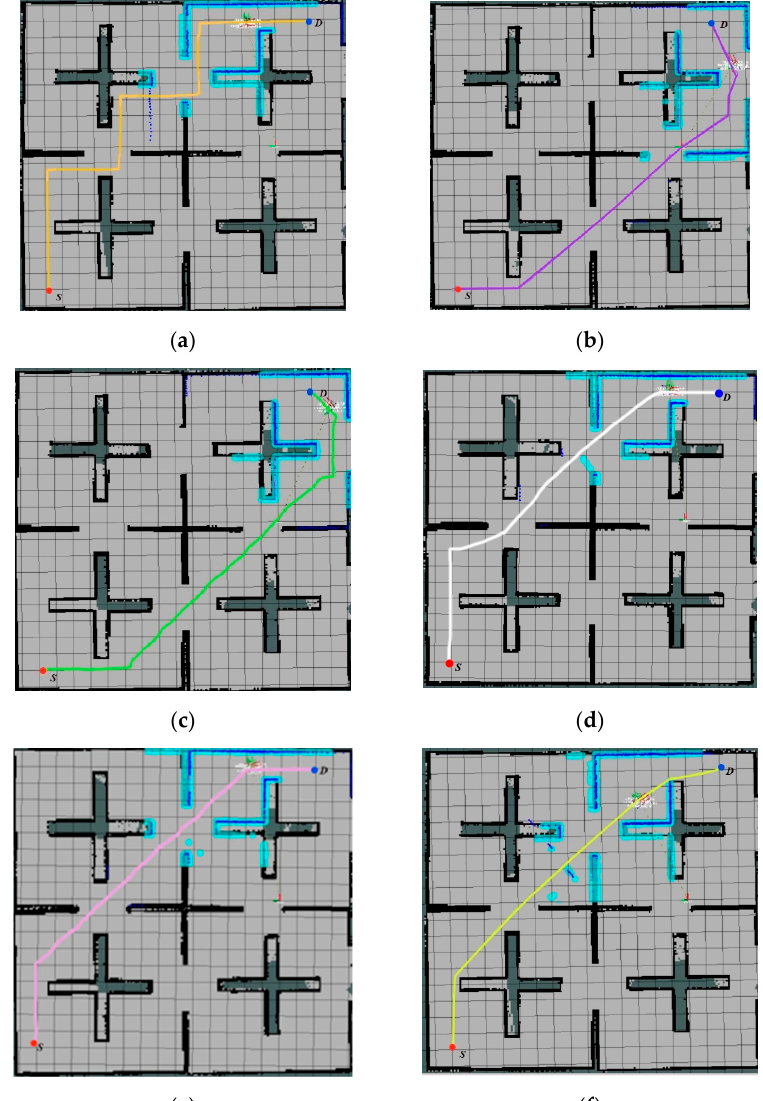
Figure 10. Simulation comparison of path planning algorithms: ( a ) Dijkstra algorithm; ( b ) Floyd algorithm; ( c ) 8-search-neighborhood A* algorithm; ( d ) 24-search-neighborhood A* algorithm; ( e )